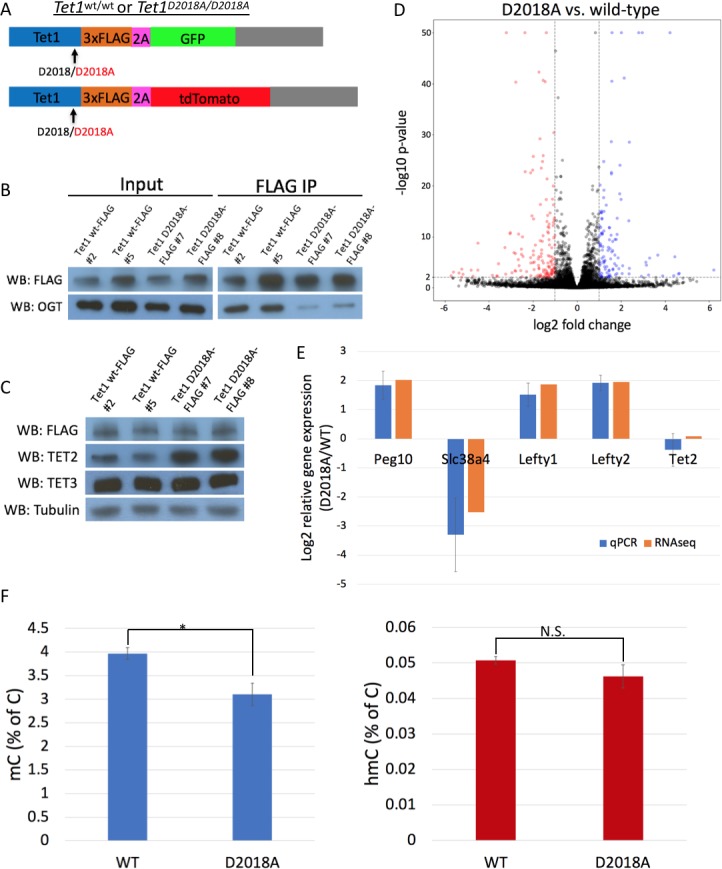
The D2018A mutation alters gene expression and 5mC levels in mESCs.(A) Schematic of WT and D2018A mESC lines. (B) FLAG and OGT western blot of inputs and FLAG IPs from WT and D2018A mESCs. (C) Western blots for FLAG, TET2, and TET3 of protein extracts from WT and D2018A mESCs. (D) Volcano plot showing differentially expressed genes in D2018A vs. WT mESCs. Red: decreased expression (log2 fold change > −1, Benjamini-Hochberg adjusted p-value<0.01). Blue: increased expression (log2 fold change >1, Benjamini-Hochberg adjusted p-value<0.01) E) qPCR analysis of selected differentially expressed genes. (F) Mass spec quantification of mC and hmC levels in WT and D2018A cells. Error bars denote s.d. *p<0.05, N.S. – not significant.10.7554/eLife.34870.014Figure 6—source data 1.For Figure 6E Quantification of gene expression by RT-qPCR used for graph in Figure 6E.10.7554/eLife.34870.015Figure 6—source data 2.For Figure 6F Mass spectrometry quantification of 5mC and 5hmC in WT and D2018A mESCs, used to generate graph in Figure 6F.